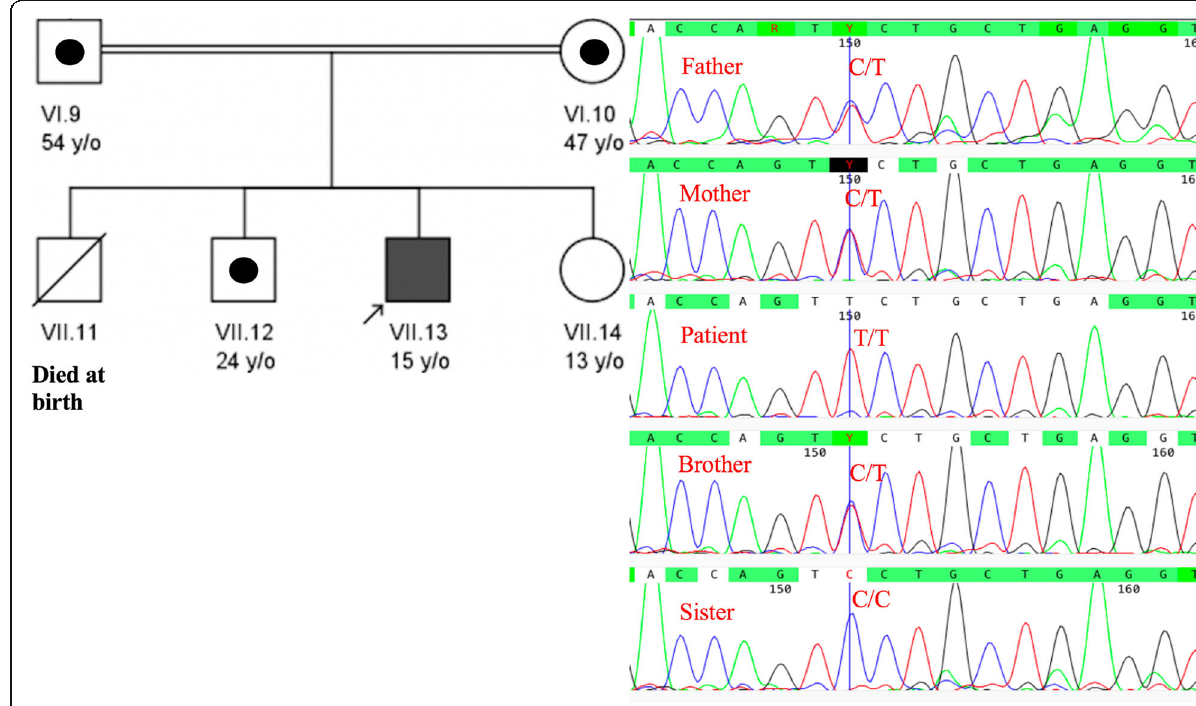
Fig. 2 Pedigree and Sanger sequencing chromatogram of family involved in this